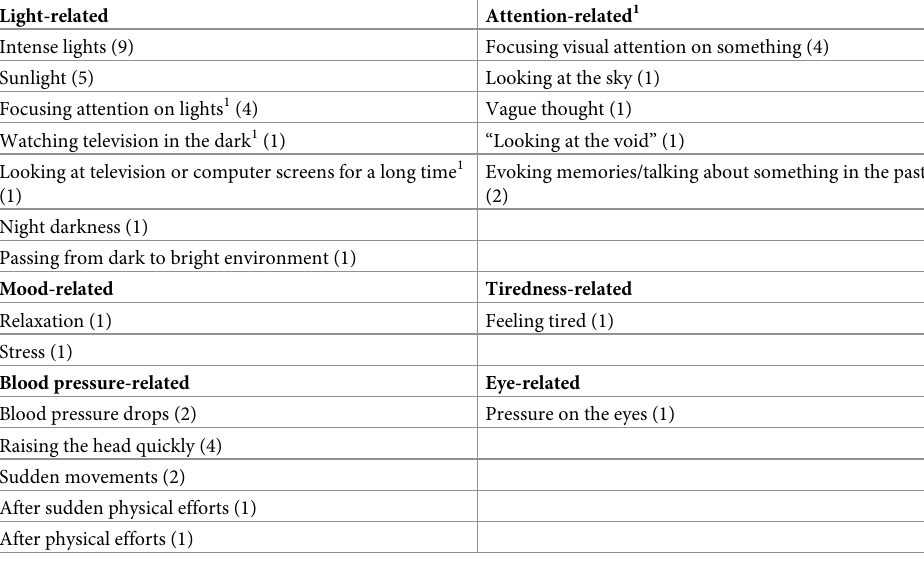
Table 6. Triggers of visual snow (Study 2; N = 35): Number of participants reporting particular types of triggers is indicated in parentheses (some participants reported more than one